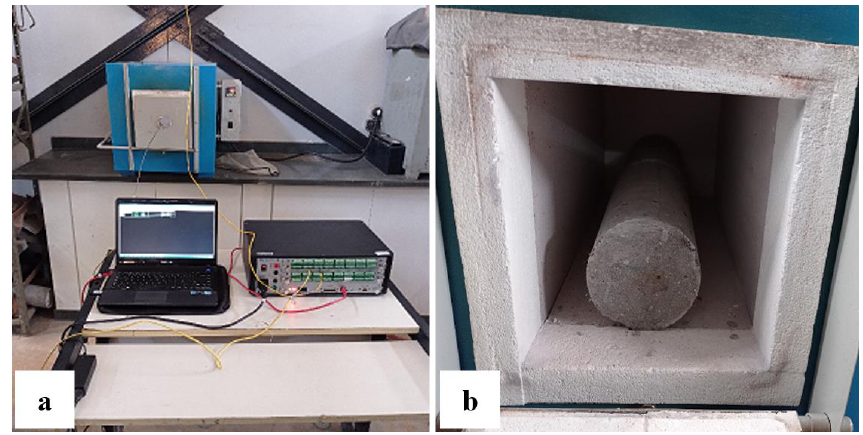
Figure 3. Heating test: ( a ) thermocouple and ( b ) specimens inside the furnace.